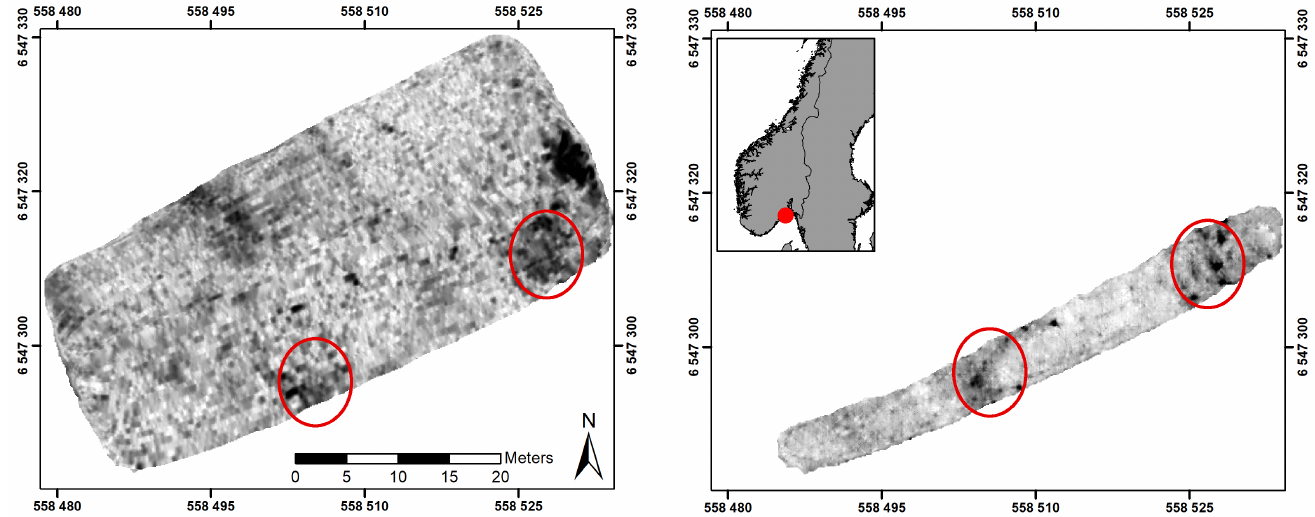
Figure 5. GPR depth-slices from 20–40cm depth acquired with the Guideline Geo MALÅ 160MHz ( left ) and Sensors & Software 500MHz antenna ( right ) at Farriseidet. The hidden stone structures, that are known from earlier archaeological investigations, are imaged as reflective, black features in the GPR data (marked with red ellipses). The extent of the survey area was reduced after initial identification of the relevant structures in the 160MHz antenna data. Coordinates are in ETRS 1989 UTM